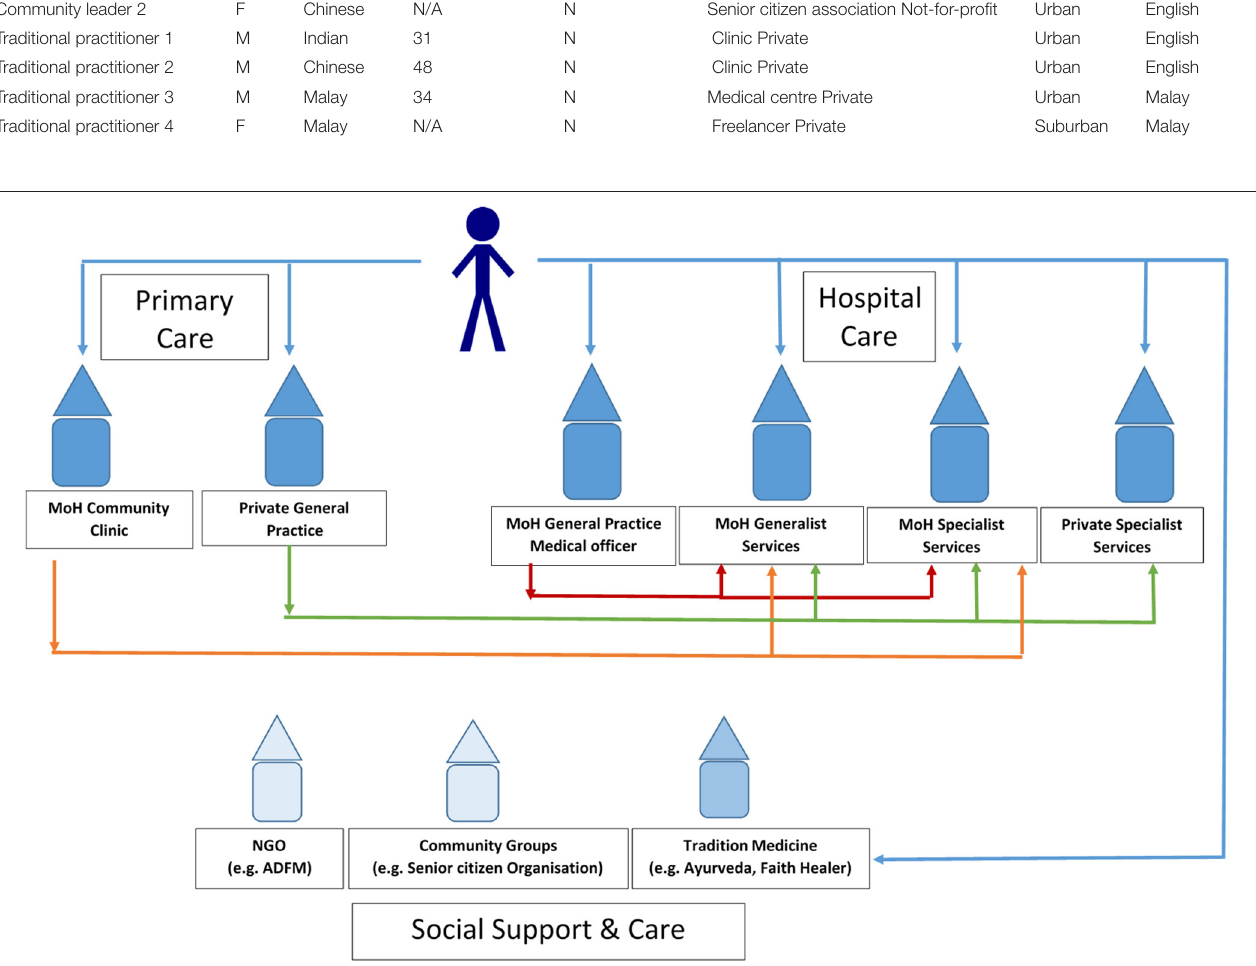
FIGURE 1 | Multiple patient routes to specialist care in Malaysia. The orange, green, and red arrows indicate several referral routes that can take a patient to specialist care. The blue arrows show the multiple routes that can take patients to specialist care and other support services.